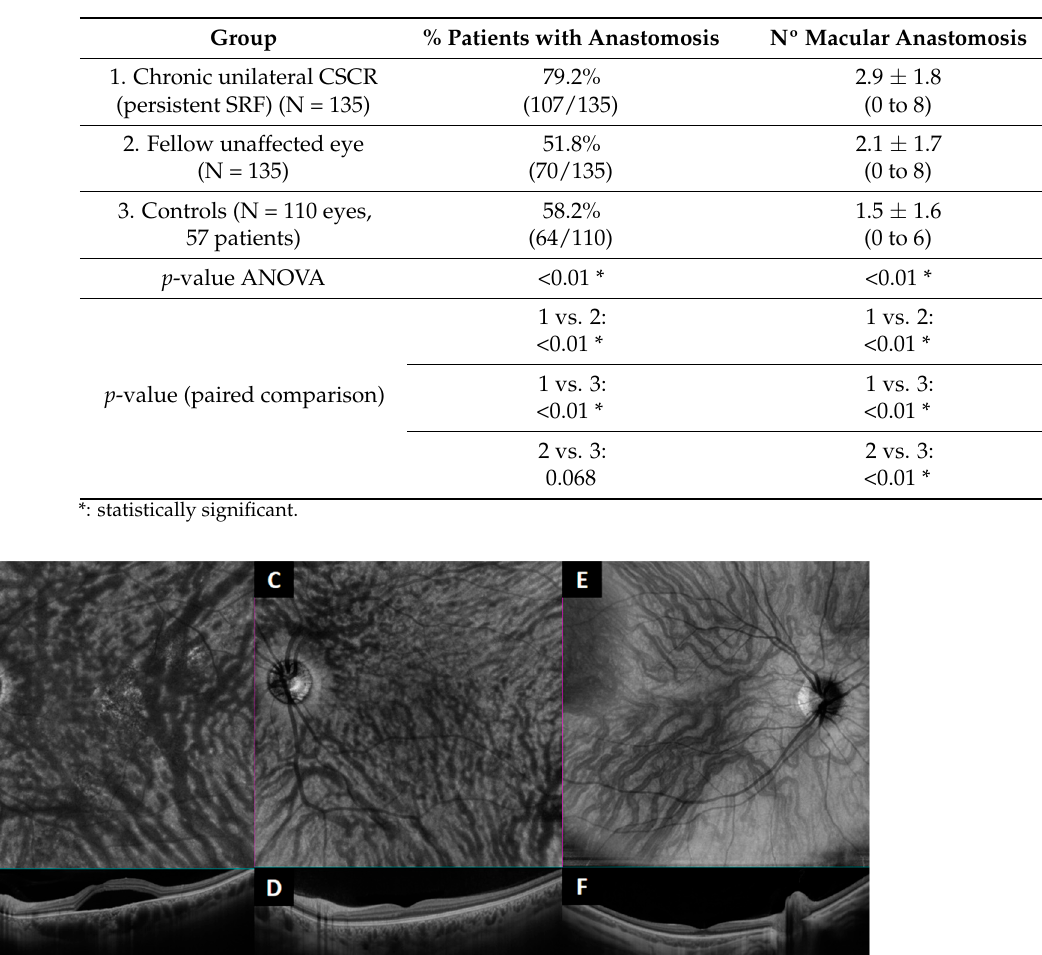
Table 1. Results of the presence and number of choroidal anastomosis assessed by En Face optical coherence tomography in the three groups studied.